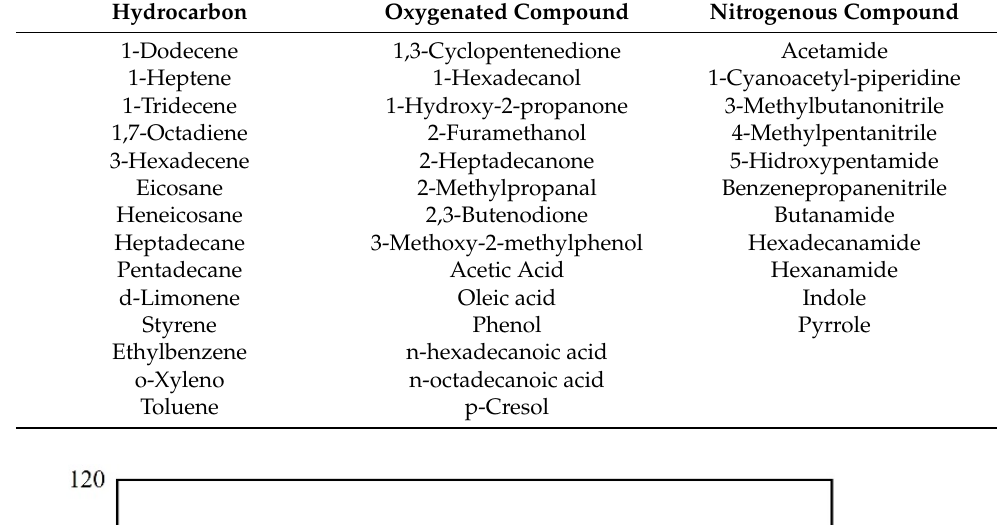
Figure 6. Proposed reaction pathway for pyrolysis of Spirulina platensis.